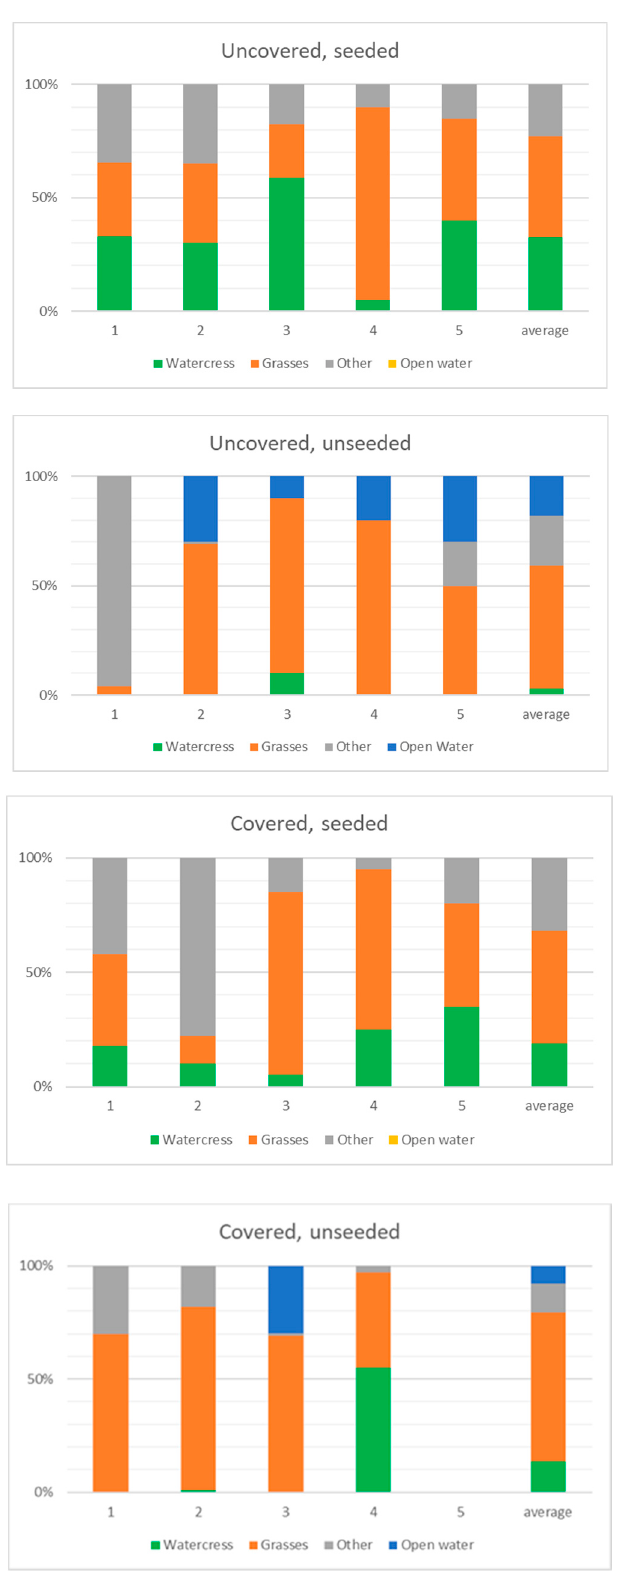
Figure 7. Percent cover of watercress, grasses, other plants, and open water in covered and uncovered, seeded and unseeded sections of ditches in May 2016. Other plants are mainly nettle (Urtica dioica), rush (Juncus effusus), with some Rumex, Violaceae, Galium, Ranunculus, Equisetum, Epilobium, and Onopordon spp.